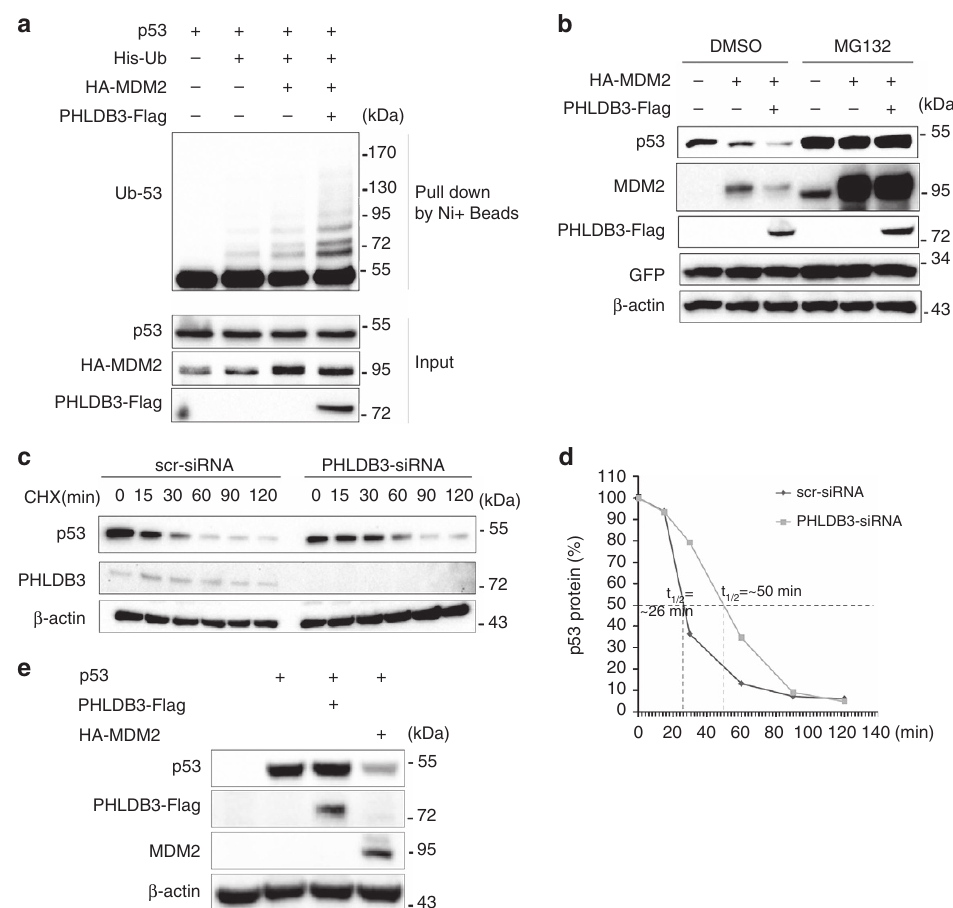
Figure 5 | PHLDB3 promotes p53 degradation by enhancing MDM2-mediated ubiquitination. ( a ) PHLDB3 promotes MDM2-induced p53 ubiquitination. HCT116 p53 (cid:2) / (cid:2) cells were transfected with combinations of plasmids encoding p53, HA-MDM2, PHLDB3-Flag or His-Ub, and treated with MG132 6h before harvested for in vivo ubiquitination assay. Bound and input proteins were detected by immunoblotting using antibodies as indicated. ( b ) PHLDB3 enhances MDM2-mediated p53 proteasomal degradation. HCT116 p53 þ / þ cells were transfected with combinations of plasmids encoding EGFP, HA- MDM2 or PHLDB3-Flag followed by immunoblotting using antibodies as indicated. MG132 was supplemented to the medium for 6h. ( c , d ) p53-half-life is increased upon PHLDB3 knockdown. HCT116 p53 þ / þ cells transfected with PHLDB3 or scramble siRNA for 72h were treated with 100 m gml (cid:2) 1 of CHX and harvested at different time points as indicated. The p53 protein level was detected by immunoblotting ( c ), quantified by densitometry and plotted against time to determine p53-half-lives ( d ). ( e ) Ectopically expressed PHLDB3 does not alter p53 protein level in the absence of MDM2. MEF p53 (cid:2) / (cid:2) ; Mdm2 (cid:2) / (cid:2) cells were transfected with combinations of plasmids encoding PHLDB3-Flag, HA-MDM2 or p53 followed by immunoblotting using antibodies as indicated. PHLDB3 lessens the chemotherapy sensitivity of HCT116 cells . Since PHLDB3 was markedly induced after chemotherapeutic drug treatment of p53-containing cancer cells (Fig. 1), we next determined if PHLDB3 has any effect on the chemo-sensitivity of these cancer cells. First, we tested the effect of ectopic PHLDB3 on apoptosis induced by these cytotoxic drugs. Interestingly, ectopic PHLDB3 reduced the basal level of apoptosis of HCT116 p53 þ / þ cells and could even significantly downgrade the Doxorubicin- or 5-Fu-induced apoptosis of the cancer cells (Fig. 7a,b) by reducing the protein level of p53 and of its target Puma, which was induced by the two drugs (Fig. 7b), as well as reducing cleaved PARP (Fig. 7b). Next, we carried out a set of cell survival assays by treating either HCT116 p53 (cid:2) / (cid:2) or HCT116 p53 þ / þ cells with these two drugs. Compared with the control group, PHLDB3 depletion significantly sensitized HCT116 p53 þ / þ cells to 5-Fu and Doxorubicin, with IC 50 reduced from13.76 to 6.43 m M for 5-Fu and from 0.07 to 0.03 m M for Dox, respectively (Fig. 7c,d), but did not show a significant effect on the sensitivity of HCT116 p53 (cid:2) / (cid:2) cells to the two drugs (Fig. 7e,f). Again, this result with Doxorubicin was also repro- ducible in lung cancer cell lines, H460 and H1299 NATURE COMMUNICATIONS|7:13755|DOI: